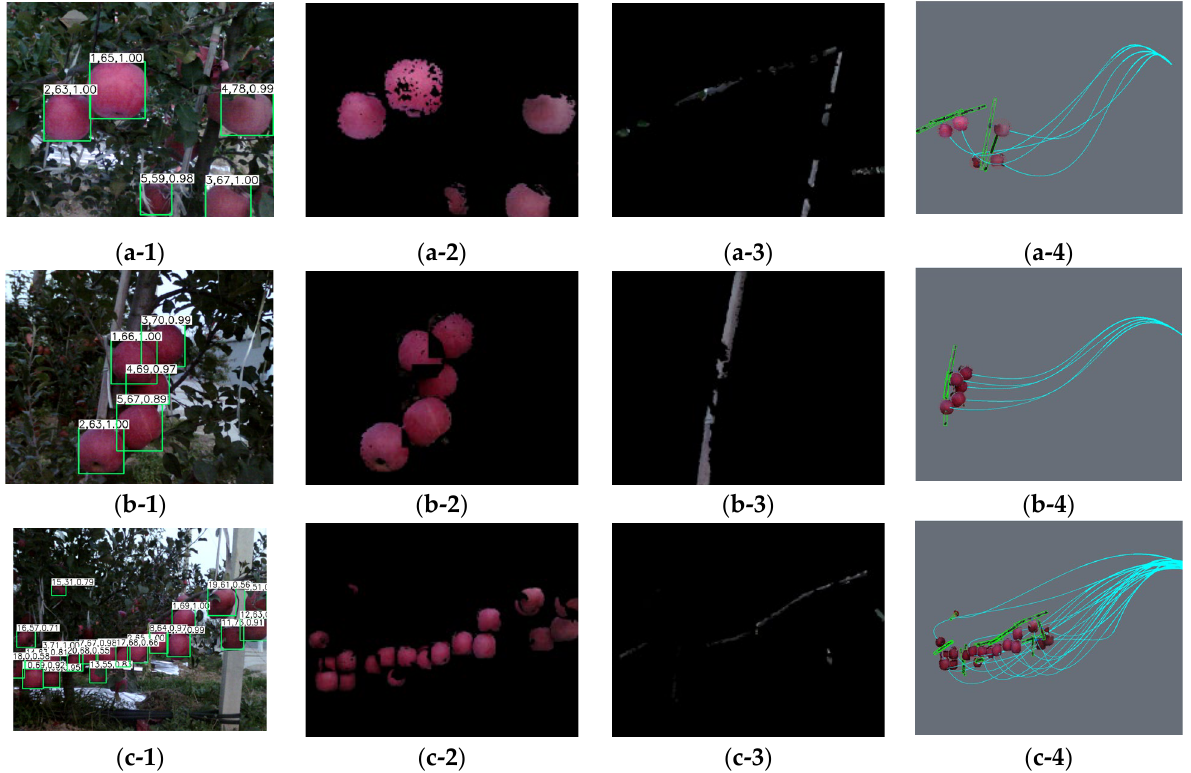
Figure 10. Experimental diagram of the apple-picking path planning algorithm. The first column shows the apples identified by the YOLOv3 algorithm, the second column shows the segmented apple surface point cloud, the third column shows the segmented branch surface point cloud, and the fourth column shows the calculated fruit-picking trajectory.